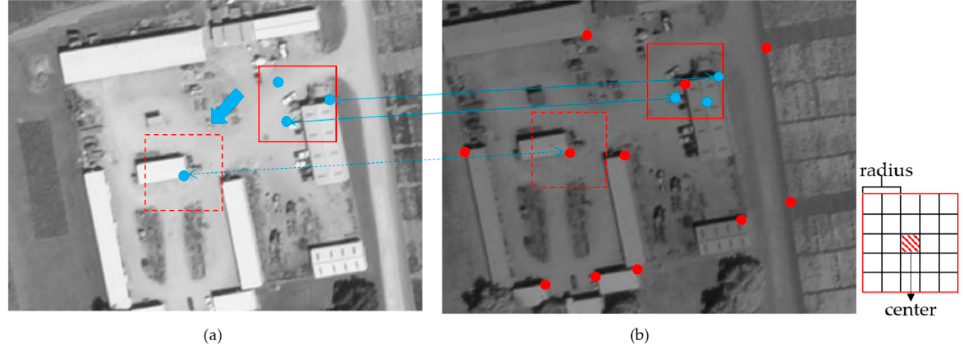
Figure 8. Diagram of window selection and local matching: ( a ) sensed image, a grayscale RGB image; and ( b ) reference image, a grayscale NIR image. This set of images is the Local Set II. The feature points (the red points in Figure 8b) were first extracted from the reference image. A window was centered on one of the feature points, and then a pair of windows (the red solid line squares) for the pair of subimages with the same size was obtained. For each pair of subimages, the reference subimage (the image within the red solid line square in Figure 8b) was specified to the sensed subimage (the image within the red solid line square in Figure 8a) by histogram specification in order to enhance contrast. Afterwards, the feature points (the blue points within the red solid line squares) of the pair of subimages were extracted and the pairs were matched (the blue lines). After the center of the window was moved to the next reference feature point (the next red point), the process iterated until all of matching pairs were detected in the entire images.